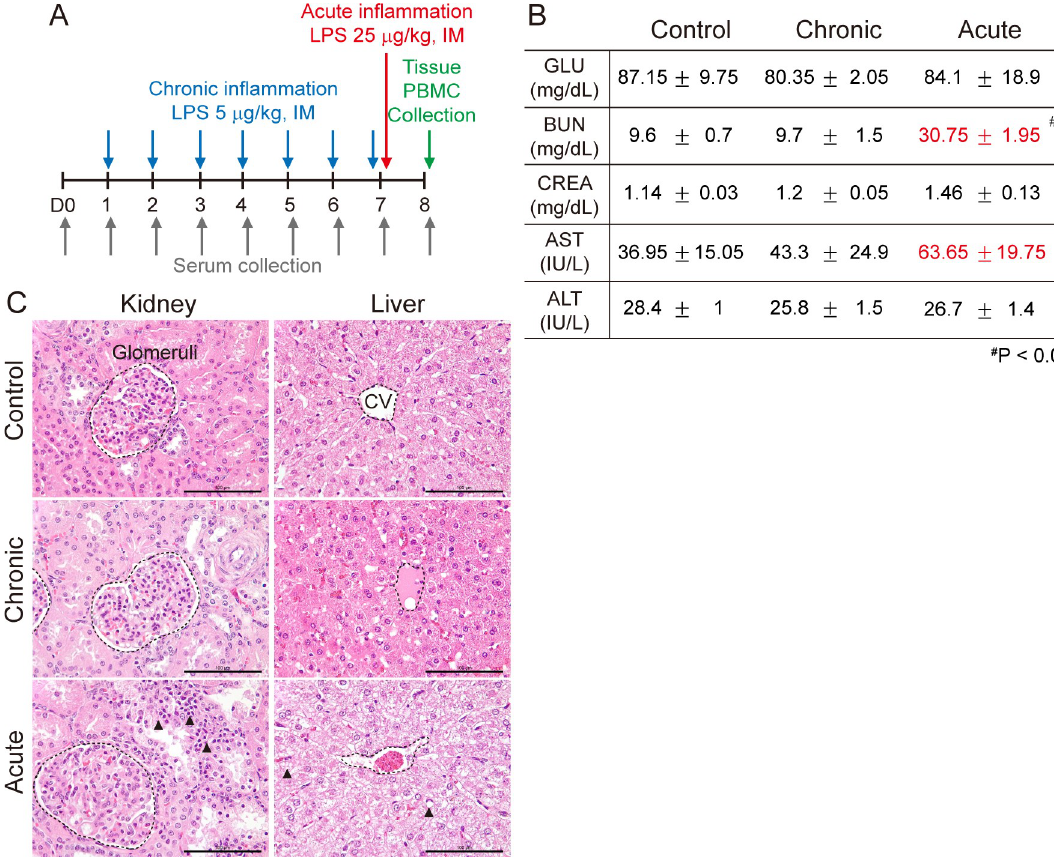
Fig 1. Comparison of serum chemistry and histopathology. (A ) Experimental schematic: For chronic inflammation, 5 μ g/kg lipopolysaccharide (LPS) was administrated, intramuscularly (IM), seven times, daily. For acute inflammation, 25 μ g/kg LPS was administrated, IM, once at day7. Two CMS minipigs were used for each group (control, chronic, acute). Blood and tissue were sampled for further study. (B) Serum chemistry was measured using a TBA 120 FR chemistry analyzer (Toshiba Co., Japan). Absolute values are indicated. # P < 0.05. (C) H&E staining. Glomeruli in kidney and central vein in liver are indicated with a black dot line. Abnormal lesions are indicated with black arrow head. Scale bar = 100 μ